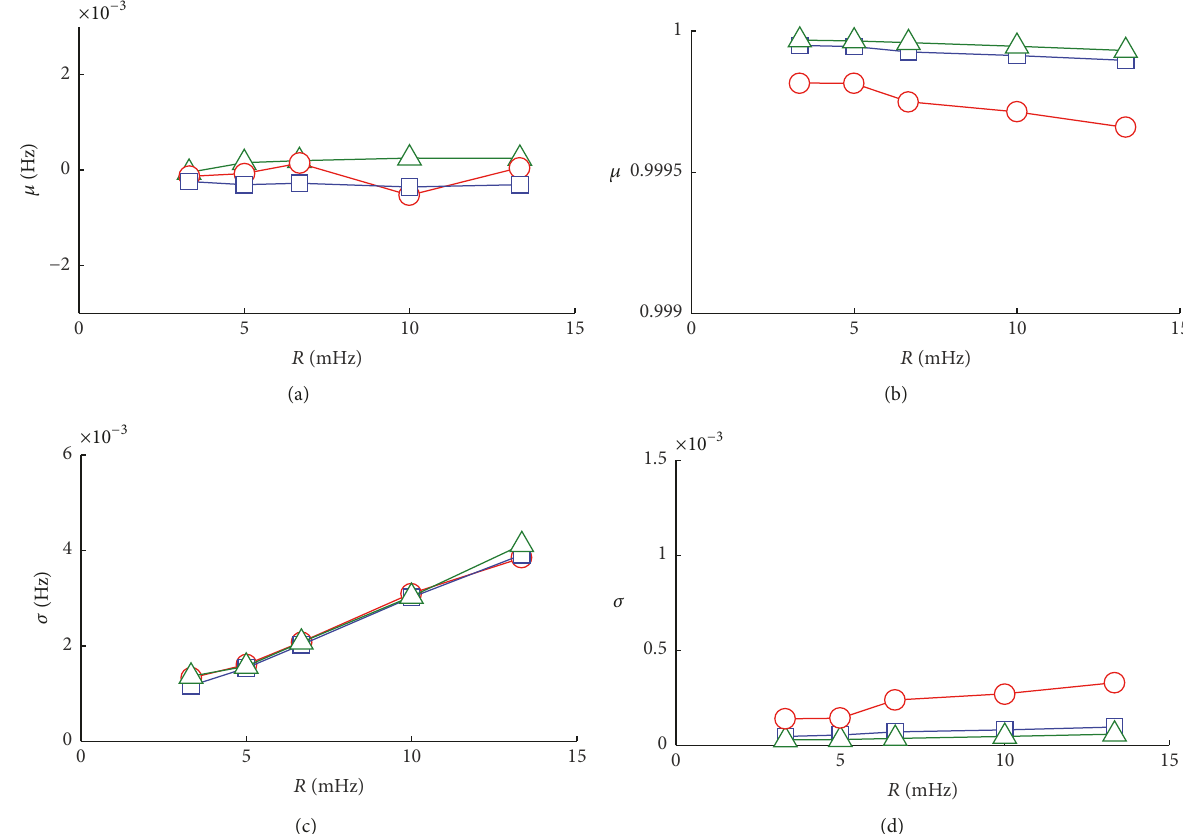
Figure 5: Results of the MCMC simulations for FDD as function of R : mean value of the error for the eigenfrequency estimation ( 𝑁 = 48 ) (a), mean value of the MAC ( 𝑁 = 36 ) (b), 𝜎 of the error for the eigenfrequency estimation ( 𝑁 = 48 ) (c), and 𝜎 for the MAC ( 𝑁 = 36 ) (d). Curves with squares ( ◻ ) for the first mode, with circles ( I ) for the second mode, and with triangles ( 󳵻 ) for the third mode.